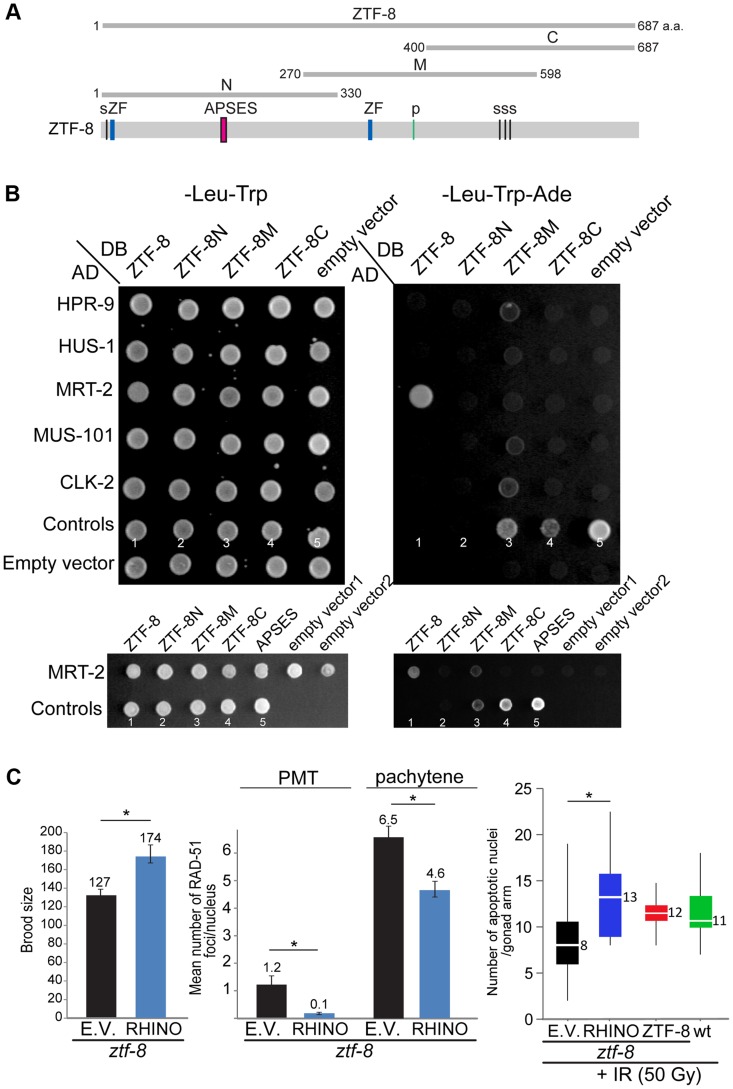
ZTF-8 interacts with MRT-2/Rad1 and shares functional conservation with mammalian RHINO.
A. Schematic representation of the region of ZTF-8 used in the yeast two-hybrid assay. B. The yeast two-hybrid system was used to test the protein interactions between ZTF-8, HPR-9, HUS-1, MRT-2, MUS-101 and CLK-2. Both full length and truncations of ZTF-8 were examined. Only full length ZTF-8 interacts with MRT-2. A mutation (SSLCPNA to AAAAAAA) at the predicted DNA binding site (APSES) in the N-terminal region of ZTF-8 abrogates its binding interaction to MRT-2. Proteins were fused to either the DNA binding domain (DB) or the activation domain (AD) of GAL4. Interactions were scored by growth on SC-Leu-Trp-Ade plates. One negative (No. 1) and four positive controls (No. 2-5) were used as described in [64]. Control No. 1: pPC97(DB) and pPC86(AD) is a negative control; control No. 2: pPC97-RB(DB) and pPC86-E2F1(AD) is a weak interaction; control No. 3: pPC97-CYH2s-dDP(DB) and pPC86-dE2F(AD) is a moderate interaction; control No. 4: pPC97-FOS(DB) and pPC86-JUN(AD) is a strong interaction; control No. 5: pCL-1(GAL4)(DB) and pPC86(AD) is a very strong interaction. C. Expression of mammalian RHINO rescues the decreased brood size, elevated levels of RAD-51 foci and reduced level of apoptosis observed in ztf-8 mutants. ztf-8 mutant worms expressing RHINO are compared to ztf-8 mutants carrying either an empty vector (E.V.) or wild type ZTF-8 as a control. Brood size, P = 0.0128 by the two-tailed Mann-Whitney test, 95% C.I. n = 13 worms for control and n = 5 for RHINO. Levels of RAD-51 foci were scored in nuclei at the premeiotic tip (PMT, zone1) and in pachytene (zone 5), P<0.0001 for both PMT and pachytene regions by the two-tailed Mann-Whitney test, 95% C.I. In the PMT, n = 171 (control) and n = 249 (RHINO). In pachytene, n = 81(control) and n = 127 (RHINO). Levels of apoptosis are measured 20 hours after exposure to γ-IR (50 Gy). Asterisk indicates statistical significance. P = 0.0004, n = 22 gonads for empty vector, n = 20 for RHINO, n = 16 for ZTF-8 and n = 20 for wild type.